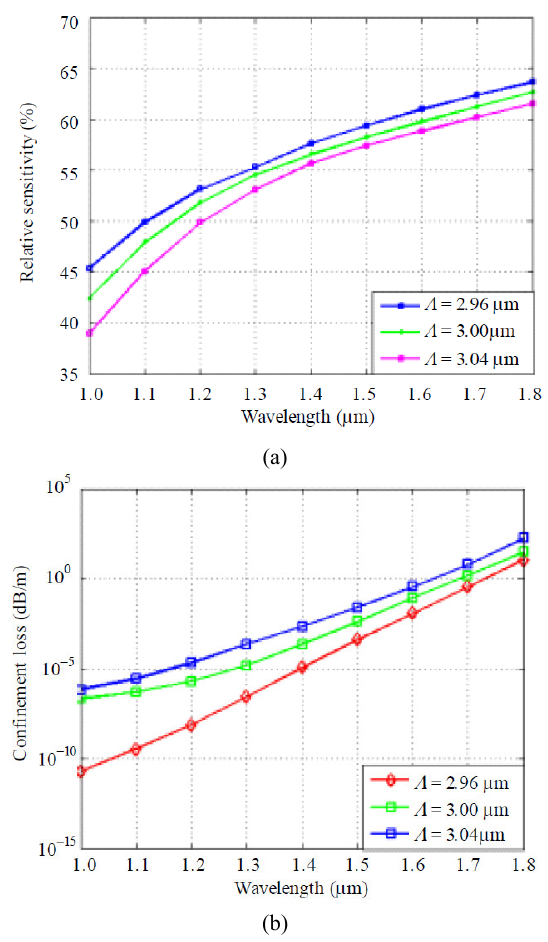
Fig. 6 Comparison between: (a) relative sensitivity versus wavelength and (b) confinement loss versus wavelength curve for the proposed H-PCF for optimized parameters:  = 2.96  m, 3.00  m and 3.04  m;  c = 1.08  m; d = 2.85  m, d c = 0.774  m, and d c 0 = 1.08  m.